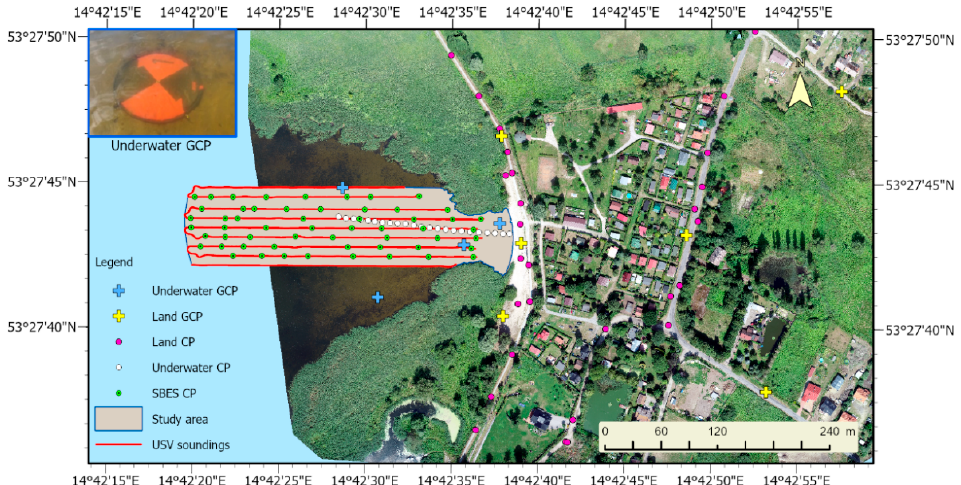
Figure 2. Map of the distribution of underwater and land-based GCPs/CPs and the USV soundings in the background of the generated UAV orthomosaic; in the upper-left corner is a photo of one underwater GCP used in data elaboration.